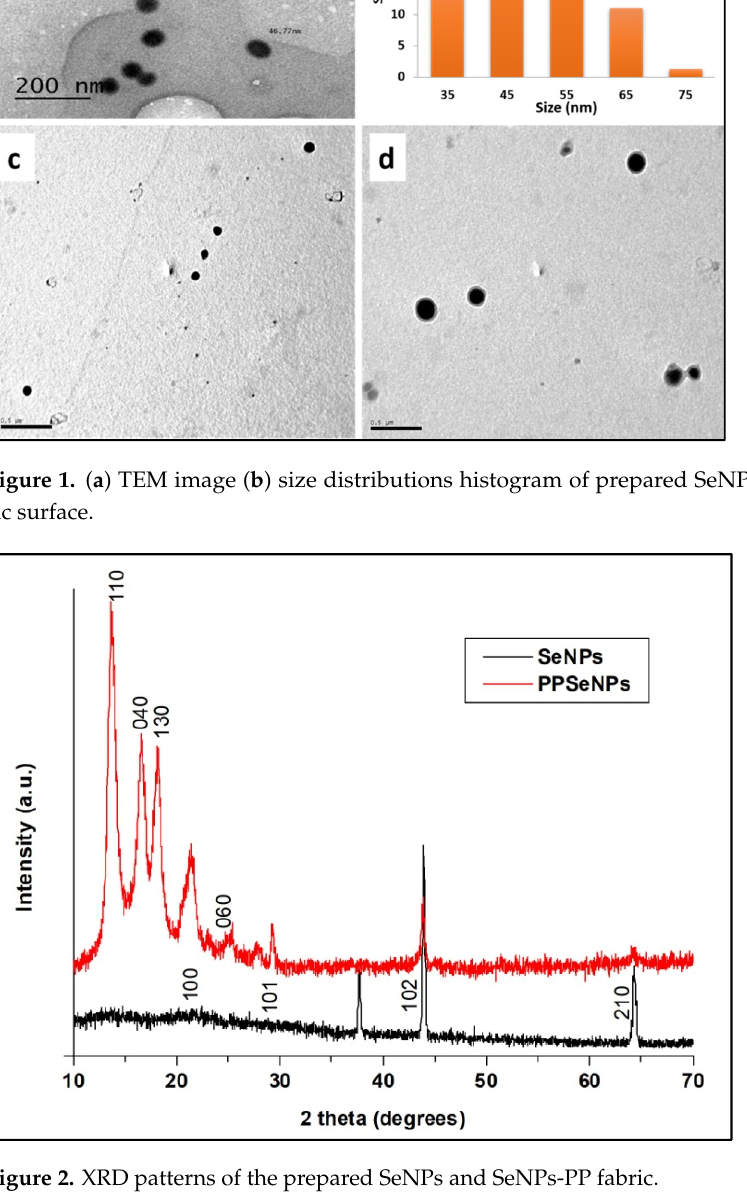
Figure 3. UV/Vis spectra of SeNPs at different concentrations. 3.2. Characterization of Poly Propylene (PP) Fabrics 3.2.1. Scanning Electron Microscopy (SEM) Analysis The SEM micrographs of the PP fabric revealed that the surface was clear with clean scales and typical fibrous structure as displayed in Figure 4. On the other hand, the SEM micrographs of the SeNPs-PP fabric show a coated layer of SeNPs into the PP fabric. Ad- ditionally, SeNPs were well distributed into the fabric. The chemical elements found on the surface of the treated PP fabric were analyzed using EDX. The peaks around 1 and 11 Kev are attributed to SeNPs. The carbon and